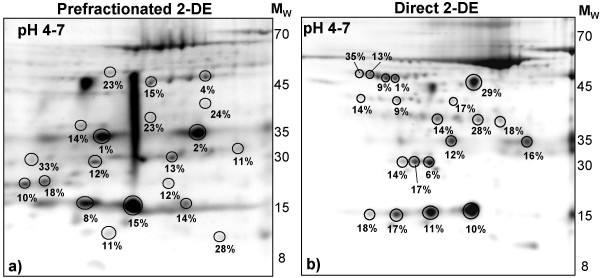
Reproducibility study of direct and prefractionated 2-DE of CSF on SYPRO Ruby stained 2-D gels. a) Represents a standard 2-D gel image of prefractionated (using LP-IEF) CSF fractions with pH 4.5–6.0, separated on a pH 4–7 IPG-strip. Numbers represents the CVs of encircled protein spots from four individually prefractionated, identical CSF samples separated by 2-DE. The mean CV of the 20 marked spots is 14.6% ± 7.9% (mean ± SD). b) Represents a standard 2-D gel image of directly analysed (after acetone precipitation) CSF proteins, separated on a pH 4–7 IPG-strip. Numbers represents the CVs of encircled protein spots from four replicate gels. The mean CV of the 20 marked spots is 15.4% ± 8.3% (mean ± SD). Molecular weights (MW) are in kDa.